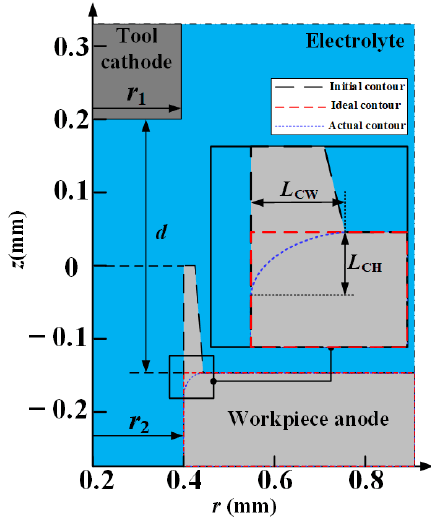
Figure 8. Schematic diagram of burr profile change.